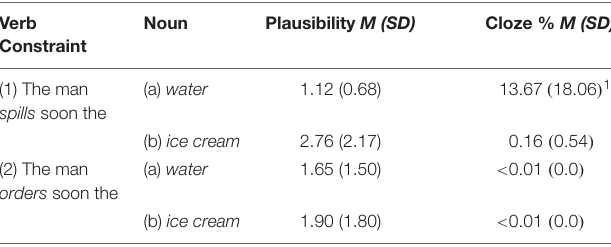
TABLE 1 | Sample items and corresponding pretest results for the two nouns in each verb condition: constraining (1) and unconstraining (2). Verb